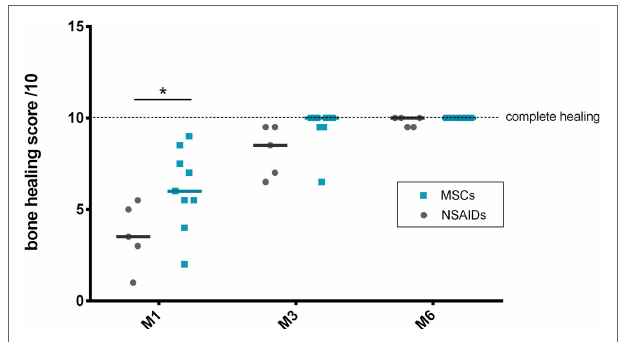
FiGUrE 2 | Bone healing scores’ comparison between the “mesenchymal stromal cells (MSCs)” and “non-steroidal anti-inflammatory drugs (NSAIDs)” groups. A significant difference was observed at M1 between the groups.